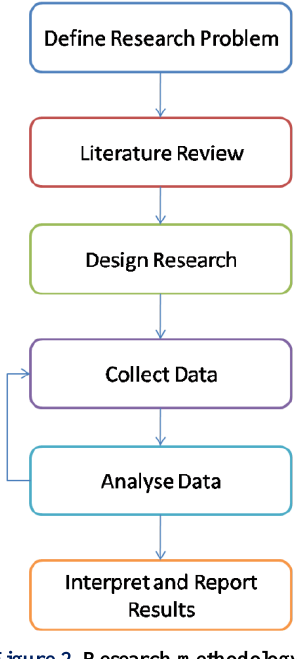
Figure 2. Research